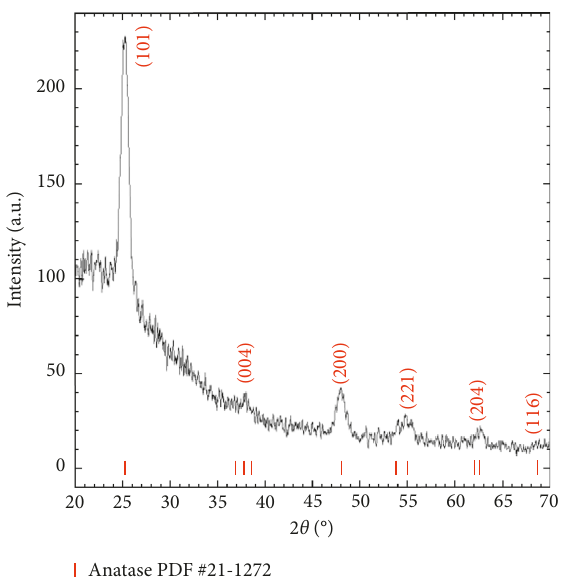
Figure 4: XRD pattern of the TiO